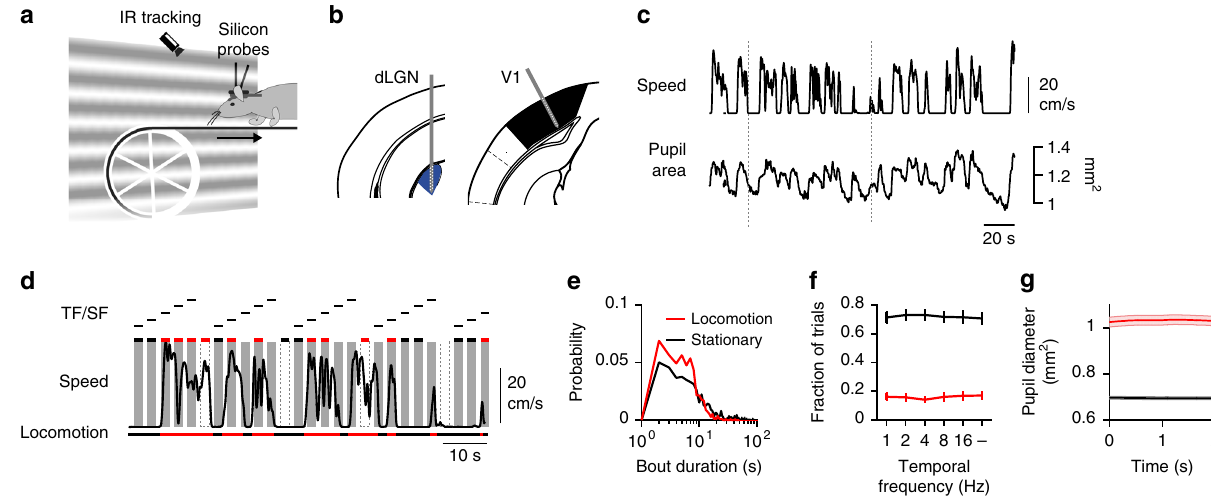
Fig. 1 Experimental setup and behavioral paradigm. a Illustration of the linear treadmill assay. Full fi eld, upward drifting sinusoidal gratings of different temporal (TF, 1,2,4,8,16 Hz) or spatial (SF, 0.01, 0.02, 0.04, 0.08, 0.16 cpd) frequencies were delivered to the right eye while animals ran on the treadmill. b Simultaneous multi-electrode recordings from dorsal lateral geniculate nucleus (dLGN, coordinates LM 2.1 AP 2.5) and primary visual cortex (V1, coordinates LM 2.5 AP 3.8). Coordinates in mm from bregma. c Locomotion speed (top) and pupil size (bottom) as a function of time. Scale bar, 20 cm/s. d Visual stimulation epochs (shaded areas) were categorized into locomotion (red) or stationary (black) trials based on locomotion speed measurements (black trace from c dashed lines). Scale bar, 20 cm/s. e Distribution of the duration of locomotion and stationary bouts (TF experiments: N = 12 mice in 23 sessions). f Fraction of locomotion (red) and stationary trials (black) for each temporal frequency (average±s.e.m. across sessions). g Pupil size as function of time for locomotion (red) and stationary (black) trials (TF experiments: 11/23 sessions with pupil size data; average ± s.e.m., N = 335 and